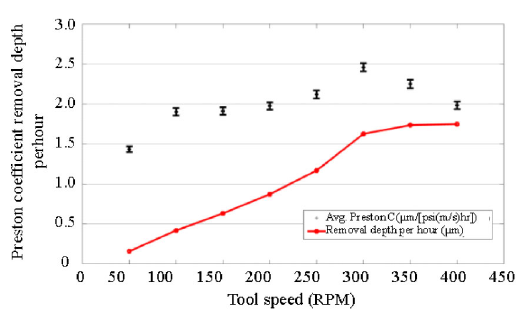
Fig. 13 Non-linearity of Preston coefficient K p over tool-speed V